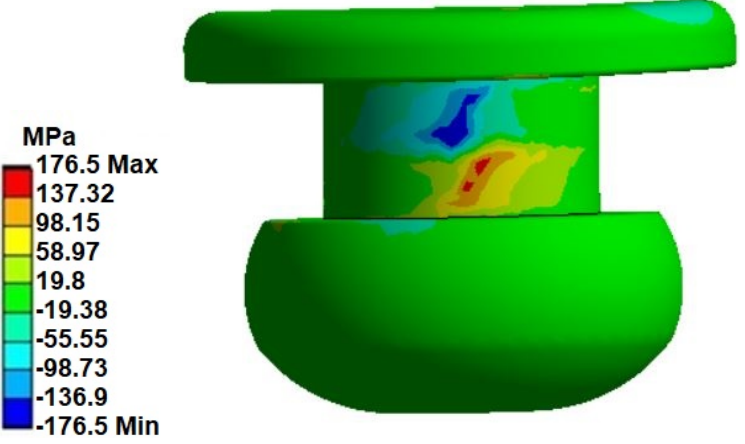
Figure 9. Shear stress (XY plan) on the rivet.